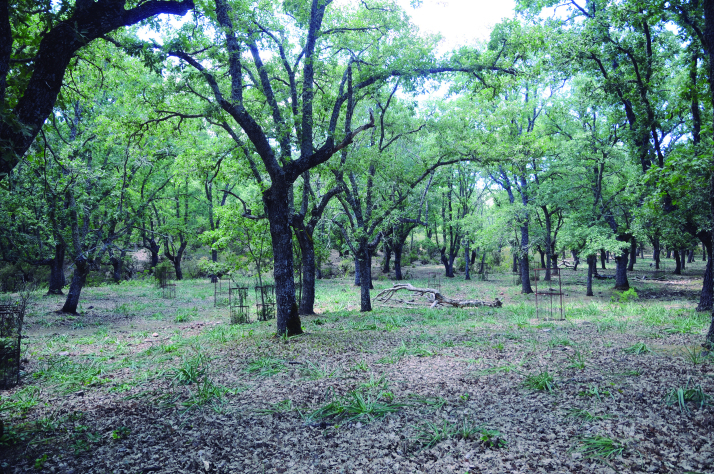
C1 plot Valle Brezoso, Q.
pirenaica